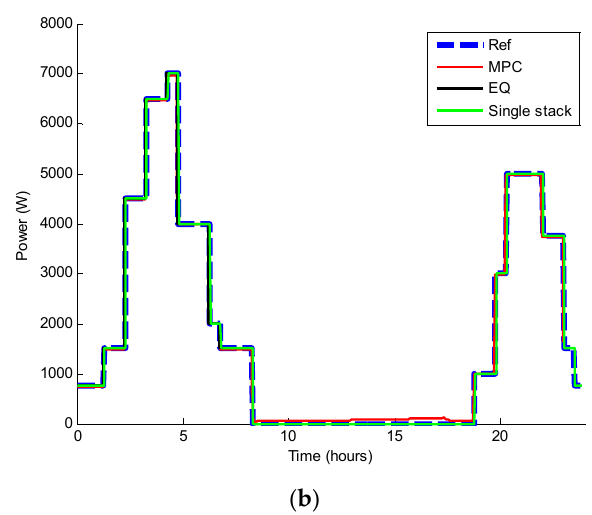
Figure 4. ( a ). Power profile required by the energy management system (EMS) of the microgrid. ( b ). Reference power tracking performance for single stack, equal power distribution, and MPC cases with respect reference power profile.